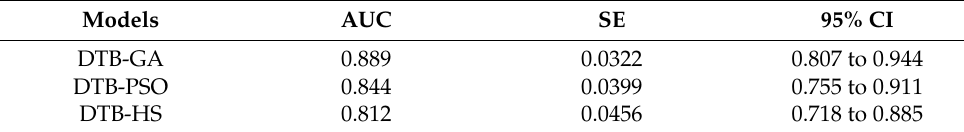
Figure 10. Evaluation of hybrid models with ROC curves. Table 6. AUC results of hybrid models.